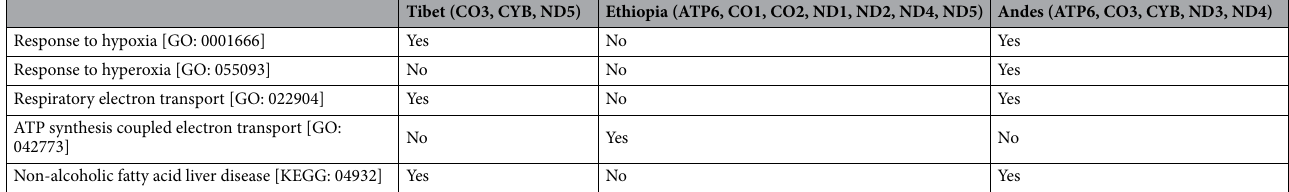
Table 3. The GO terms and KEGG pathways for gene sets described in Fig.